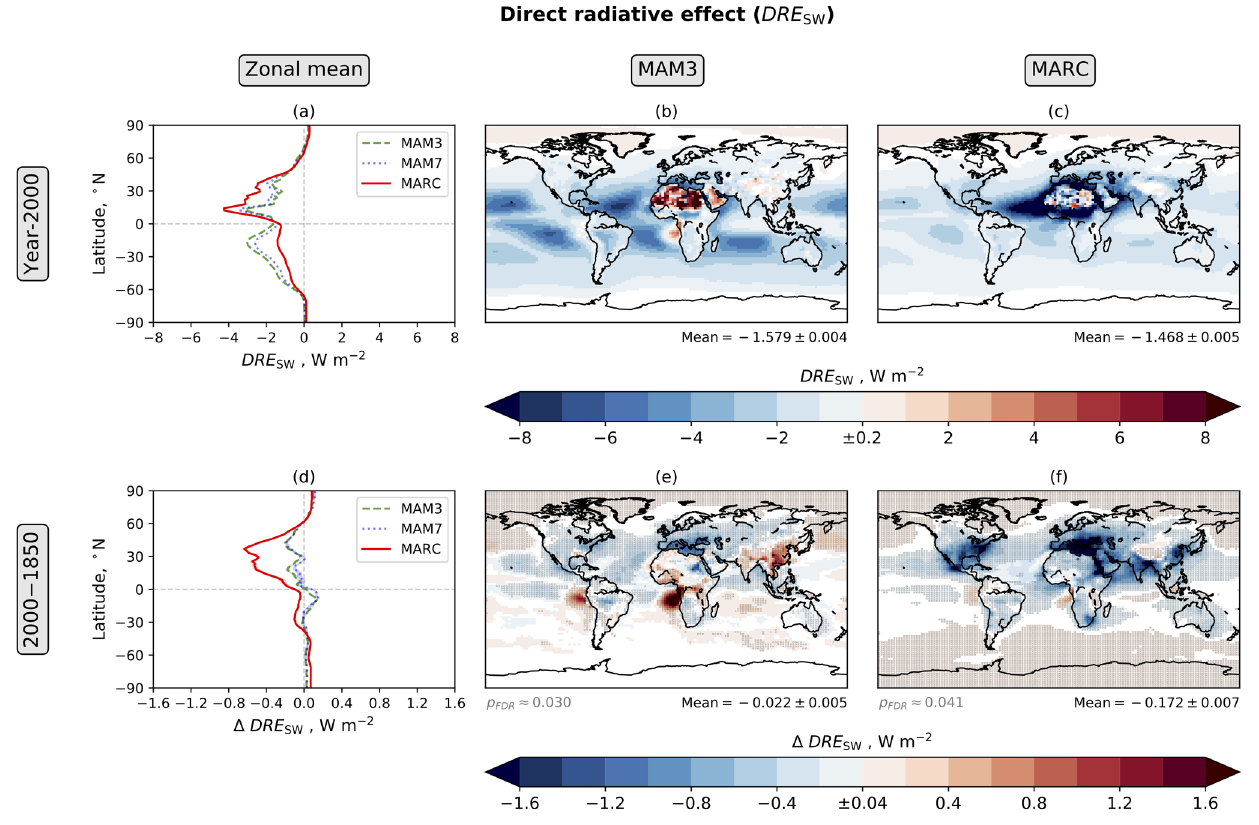
Figure 8. Annual mean direct radiative effect (DRE SW ; Eq. 3). The figure components are explained in the Fig. 2 caption. For all four maps, white indicates differences with a magnitude less than the threshold value in the centre of the corresponding colour bar. Table 5. Area-weighted global mean radiative effects. Combined standard errors are calculated using the annual global mean for each simulation year. The regional distributions of these radiative effects are shown in Figs. 8, 14, 15, 16, and 17. ERF SW + LW is the sum of the other radiative effect